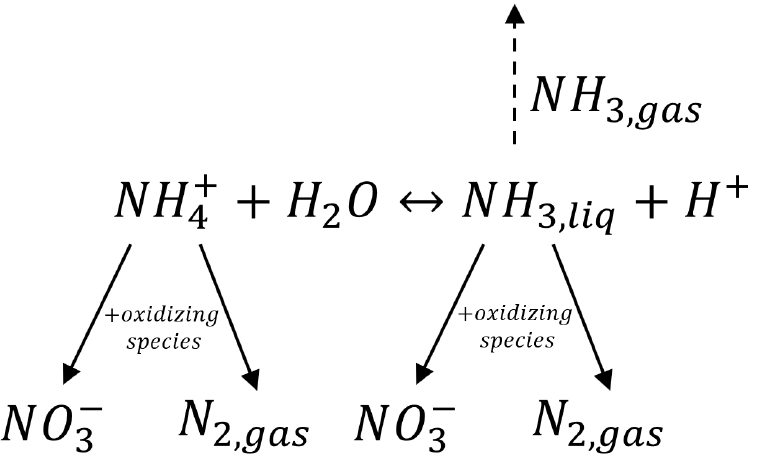
Figure 5. Simplified schematization of the nitrogen electrochemical oxidation mechanism.